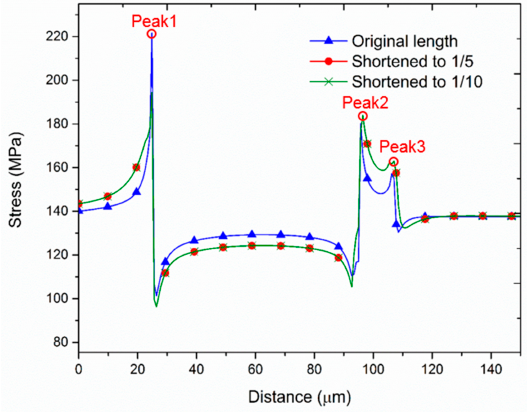
Figure 5. Stress distribution in the BLC area computed by the scaled down model.